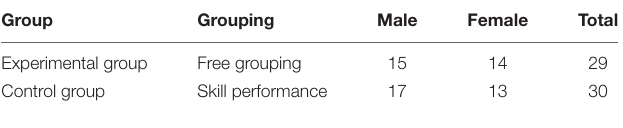
TABLE 3 | Class size statistics.